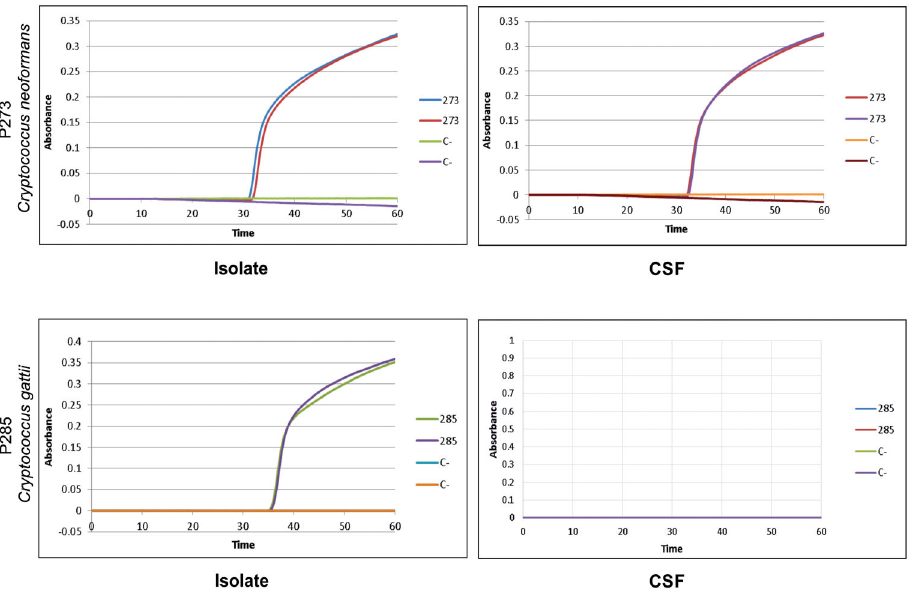
Figure 4. Representative loop-mediated isothermal ampli fi cation (LAMP) results of P273 cerebral spinal fl uid clinical sample and culture (C). Isolate of Cryptococcus neoformans showed positive results after 30 min of reaction time. P285 showed a positive result after 35 min of reaction time only for DNA extracted from the clinical isolate of Cryptococcus